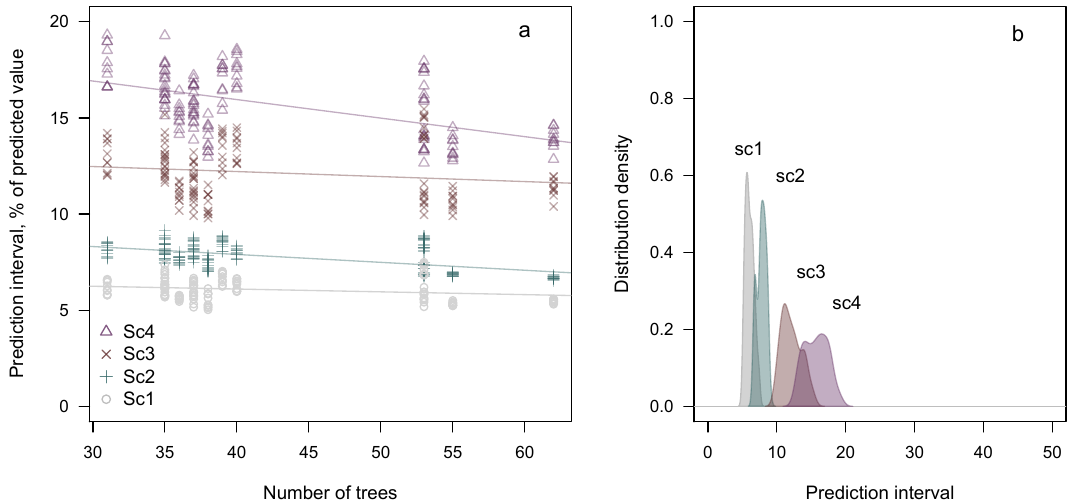
Figure 6. Plot-level annual relative prediction intervals of the biomass increment as a function of the number of trees sampled in the plot for the four scenarios (a) . Distribution density of the relative prediction interval of the biomass increment at plot level, all plots pooled (b)